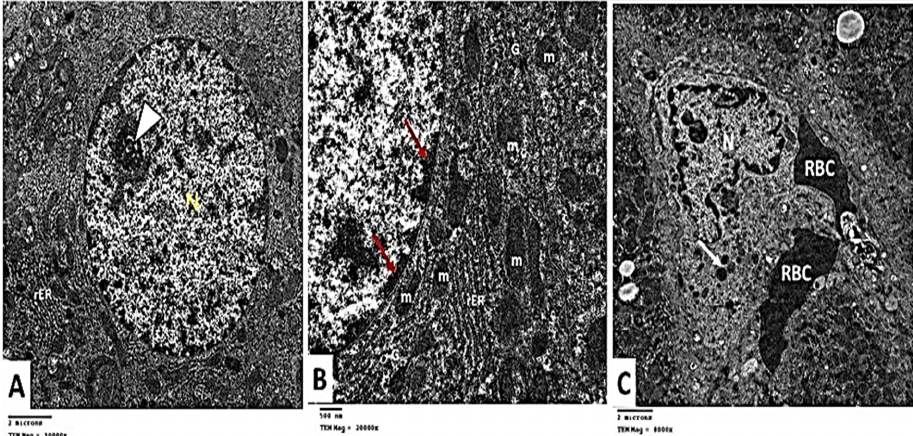
Figure 11. ( A ) Electron micrographs showing hepatocyte with rounded nucleus (N) and prominent nucleolus ( ▲ ). Rough endoplasmic reticulum (rER) is seen. Group I TEM × 10,000. ( B ) Electron micrograph showing part of the nucleus with peripheral heterochromatin ( ↑ ). Mitochondria (m) with apparent cristae are seen in association with rough endoplasmic reticulum (rER). Glycogen rosettes (G) are seen scattered in the cytoplasm. Group I TEM × 20,000. ( C ) Electron micrograph showing Kupffer cell lining blood sinusoid. Notice the large irregular nucleus (N) and lysosomes ( ↑ ) in the cytoplasm. Group I TEM × 8000.